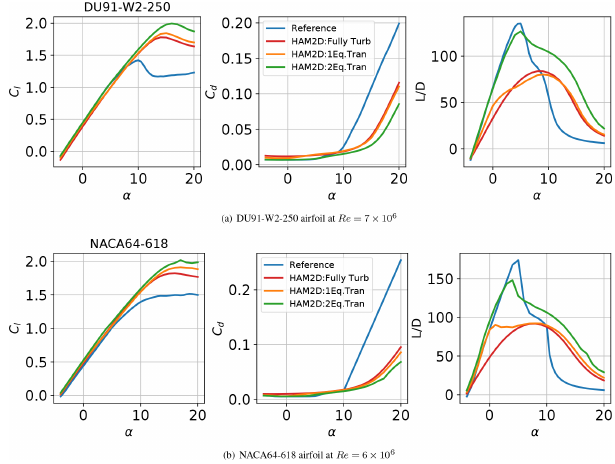
Figure 11. Aerodynamic coefficient polars for DU91-W2-250 and NACA64-618 airfoils using fully turbulent and free-transition re- sults at Re = 7 × 10 6 and 6 × 10 6 generated using HAM2D com- pared against reference data from Kooijman et al. (2003).